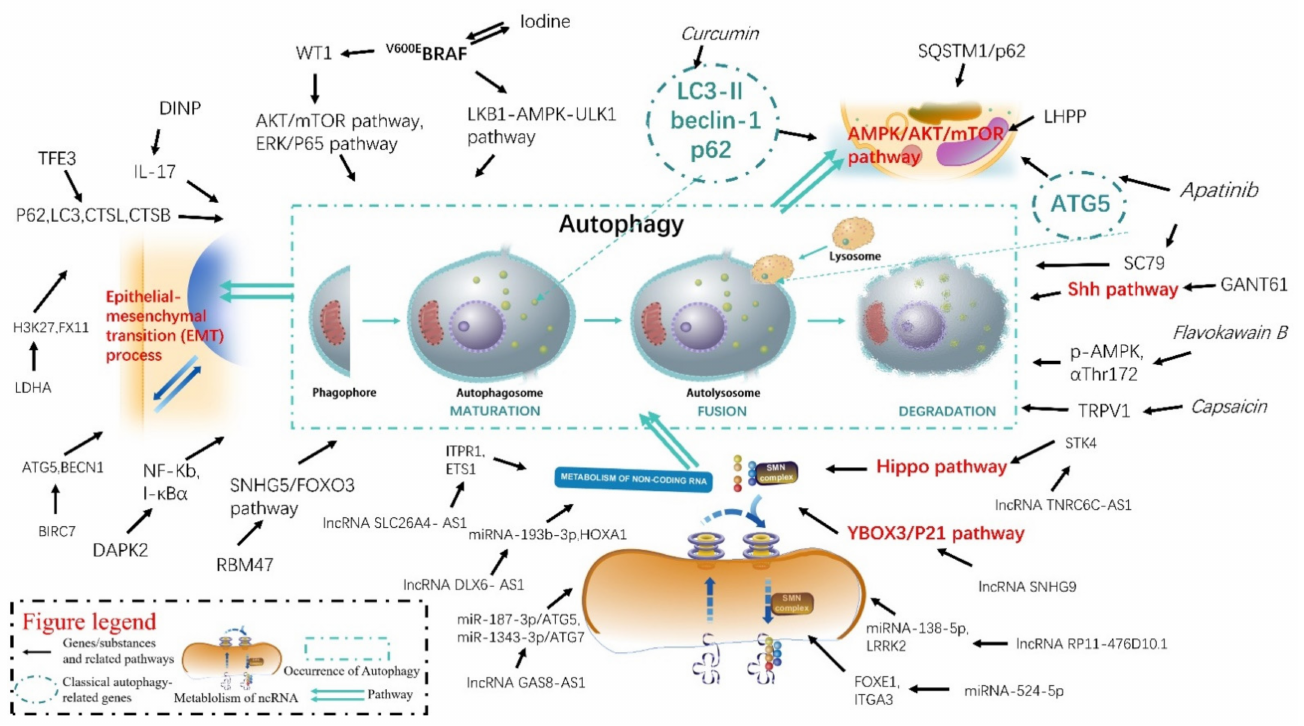
Figure 1. The mechanisms of autophagy in thyroid